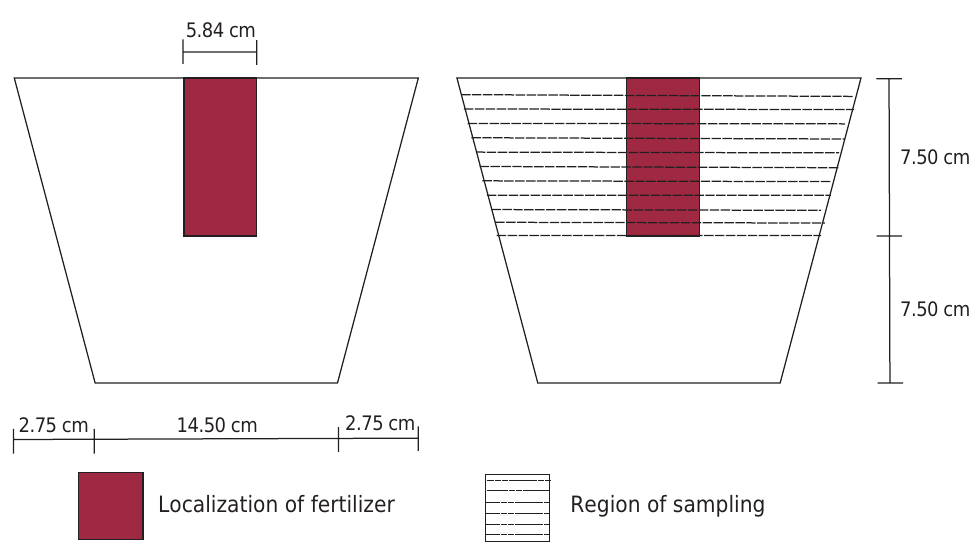
Figure 1. Scheme of the location of P fertilizer in the pots, and the collection of the soil sample after